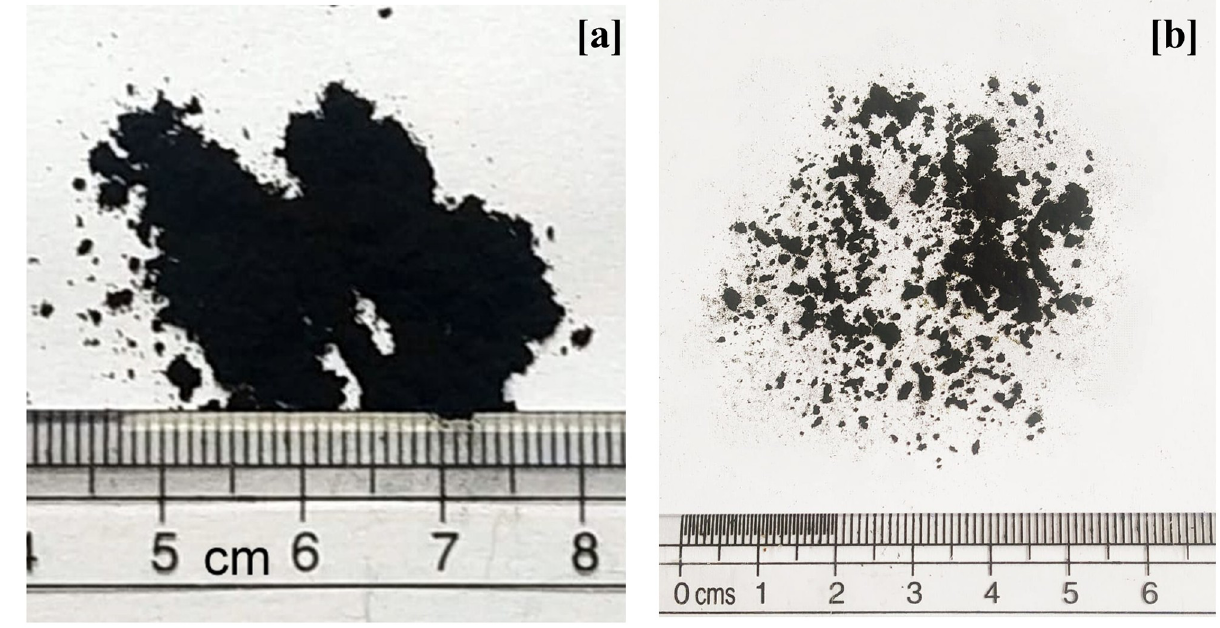
Fig 2. The physical appearance of (a) TPC (b)